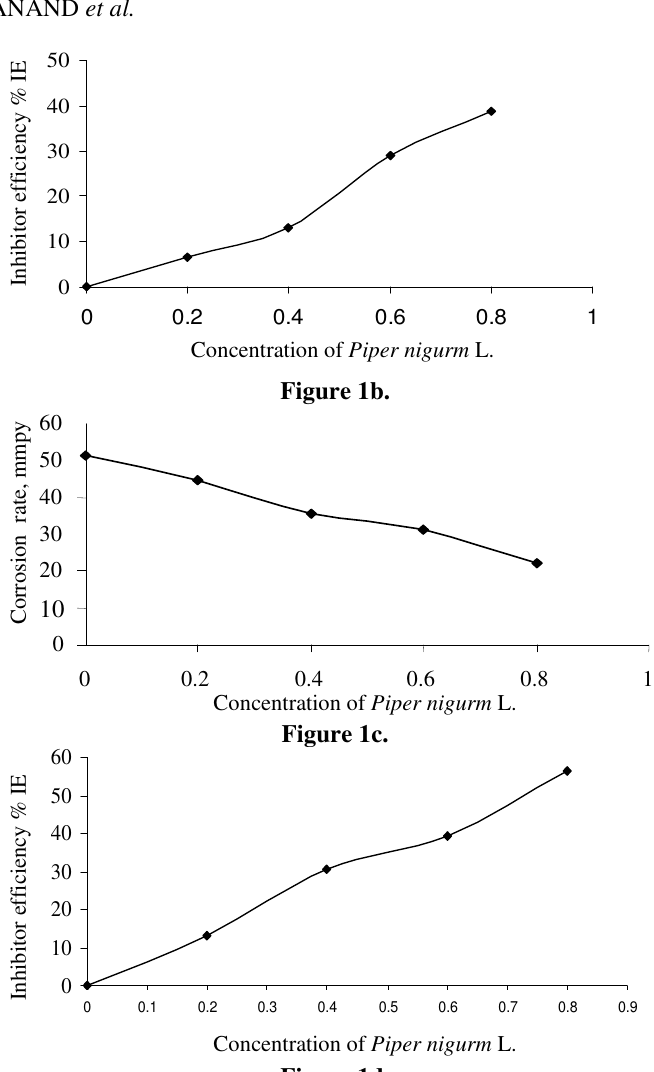
Figure 1(a). Variation of corrosion rate (CR) with concentration of Piper nigrum L (in %) in HCl solution, (b) Variation of inhibition efficiency (IE) with concentration of Piper nigrum L (in %) in HCl solution, (c) Variation of corrosion rate (CR) with concentration of Piper